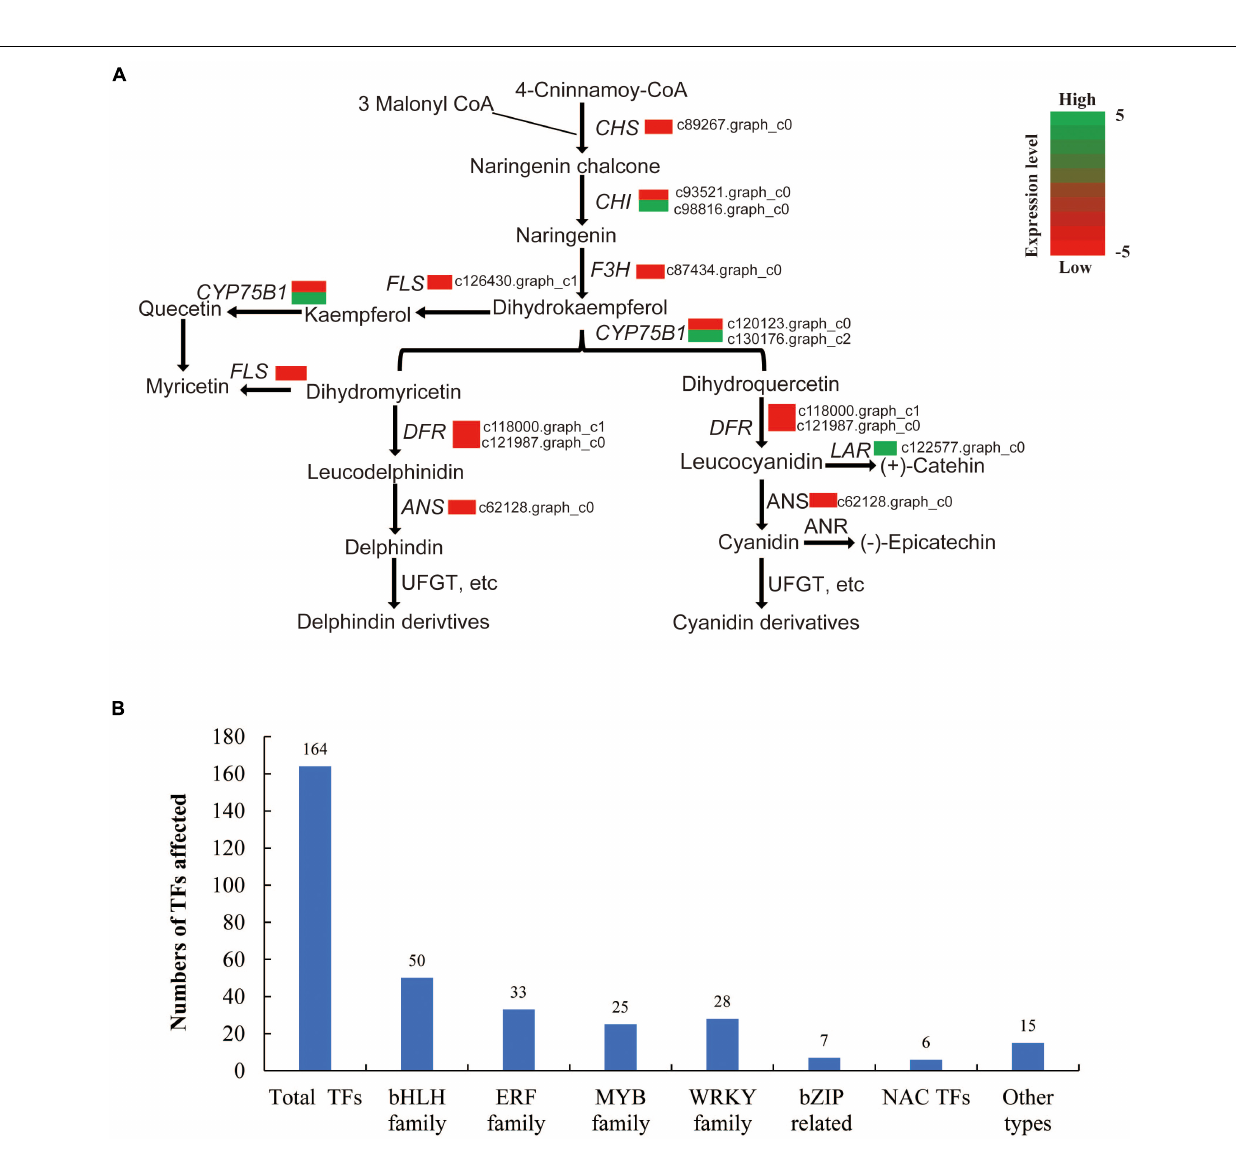
c119914.graph_c0, c107135.graph_c0, and